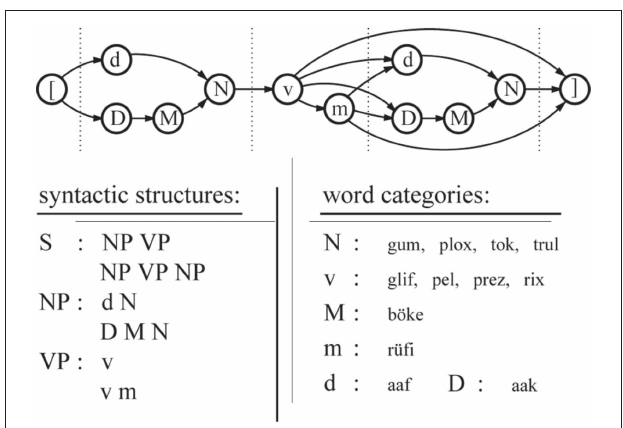
FiguRE 1 | Schematic representation of the artificial grammar of BROCANTO. Nodes in the upper panel specify word classes (nouns, verbs, etc.), while arrows denote valid transitions between nodes. A correct sentence is formed by a transition from beginning ([) to end (]). The lower panel depicts the rules according to which valid phrases are formed. Thus, a sentence (S) consists of a noun phrase (NP) and a verb phrase (VP). An NP in turn is either the sequence dN or DMN, where N is one of the possible noun choices gum, plox, tok, and trul. Word classes: N = noun; v = verb; M = adjective; m = adverb; d, D = determiner. Examples of correct and incorrect sentences (words marked with an asterisk violate